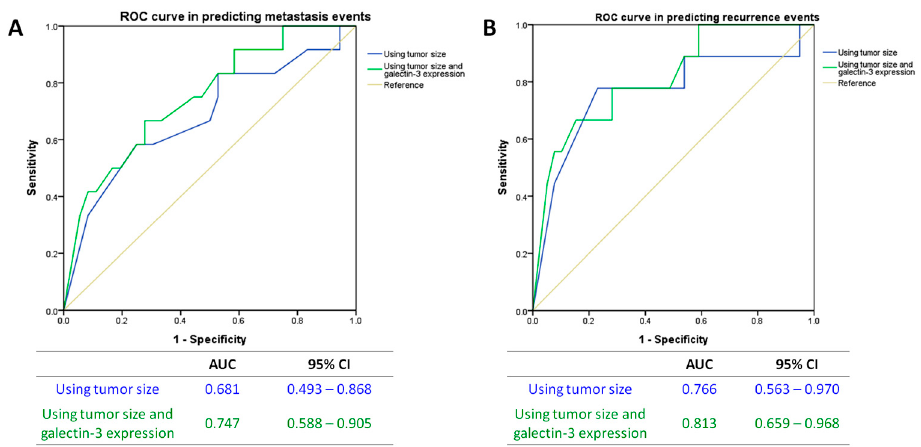
Figure 4. ROC curves in the prediction of ( A ) metastasis events and ( B ) recurrence events. ROC: receiver operating characteristic; AUC: area under curve; CI: confidence interval.